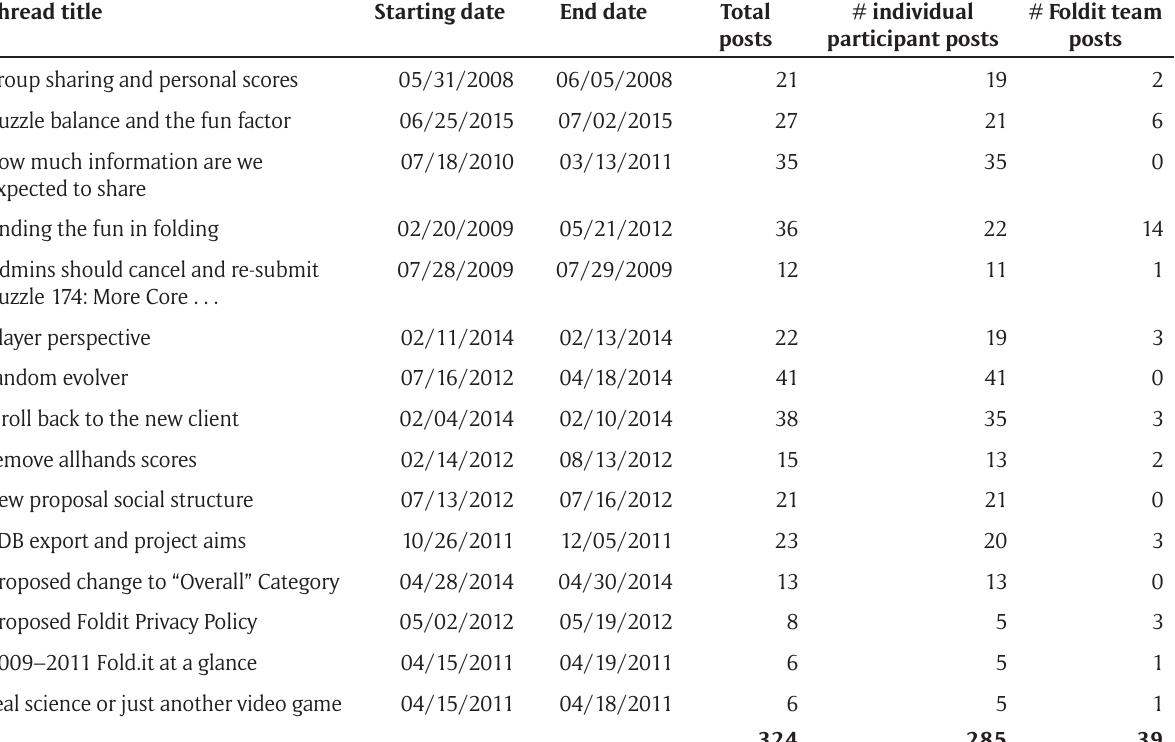
Table 1: Foldit threads selected for the